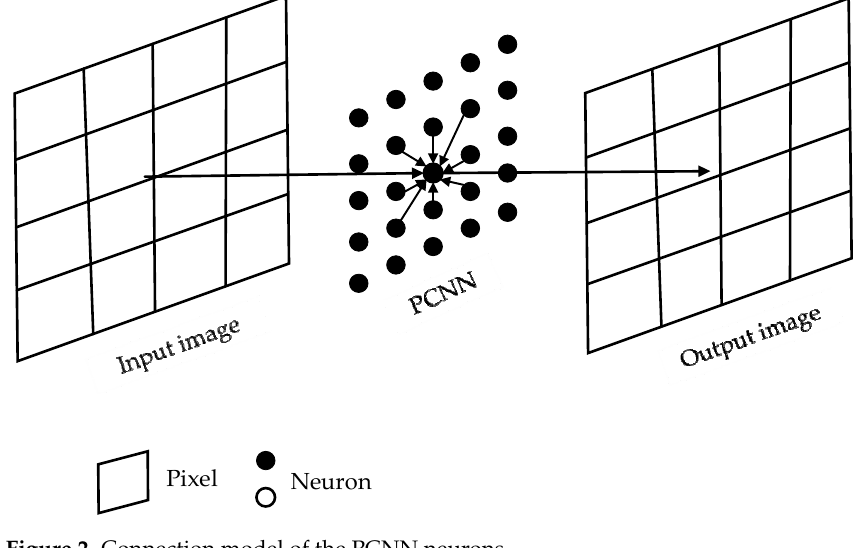
Figure 2. Connection model of the PCNN neurons.